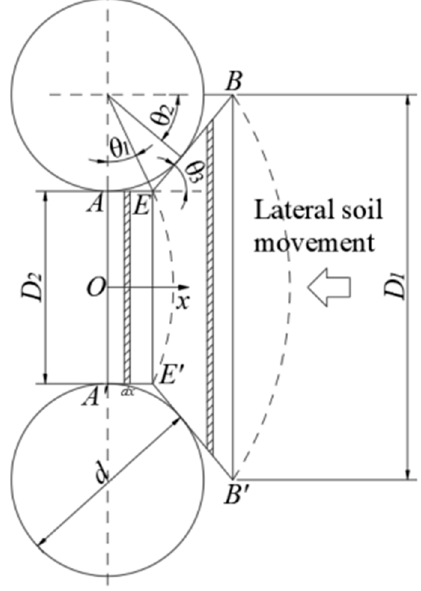
(the shaded area in Figure 4) is shown in Figure 5a,b, respectively. The static equilibrium differential equation in the x direction is given by